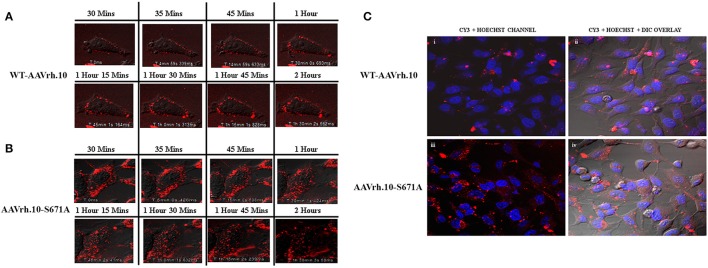
AAVrh.10 mutant vectors demonstrate increased rate of intracellular trafficking in vitro. HeLa cells were infected with Cy3 fluorescent dye labeled AAVrh.10 vectors at an MOI of 1 × 105 vgs. Images were obtained at different timepoints in an Olympus confocal microscope. Live cell images of (A) WT-AAVrh.10 and (B) AAVrh.10-S671A vectors were captured serially for 2.5 h. Twelve hours post live imaging, the cells were fixed with 4% para-formaldehyde. Cells were then observed after staining the nucleus with Hoecsht dye, and images were captured under an Olympus confocal microscope (C-i,ii) representative images of fixed cells infected with WT-AAVrh.10 and AAVrh.10-S671A are shown in the Cy3+Hoechst channel and (C-iii,iv) Cy3+Hoechst+ differential interference contrast (DIC) channel.